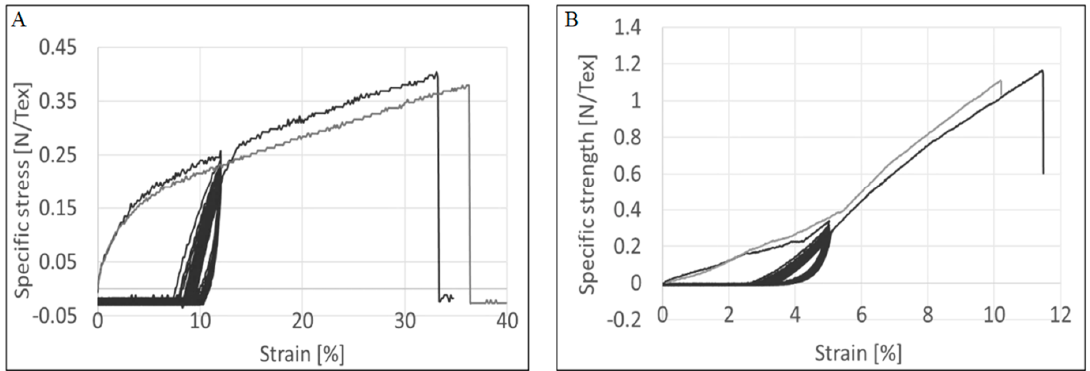
Figure 9. Failure properties of CNTY under uniaxial stretching (gray curve) vs. after 100 cycles of loading (black curve) for untreated CNTY ( A ) and post ‐ treated CNTY ( B ).